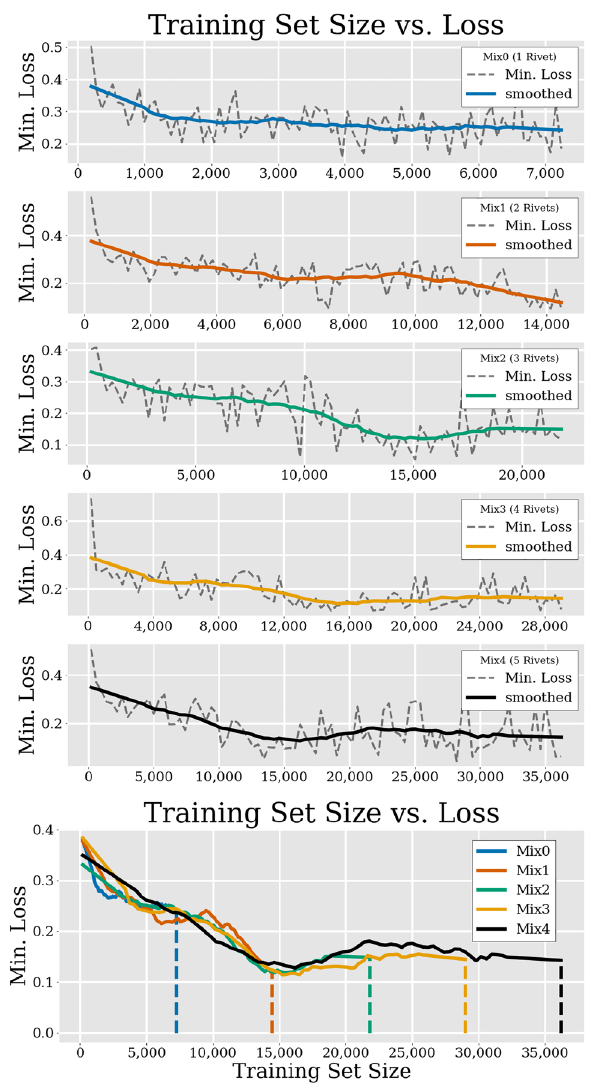
Fig. 4 First five graphs: Individual data sets and their performance with each data set size after five epochs. Bottom graph: All runs superimposed. The dashed lines indicate the entire data set size of the respective data